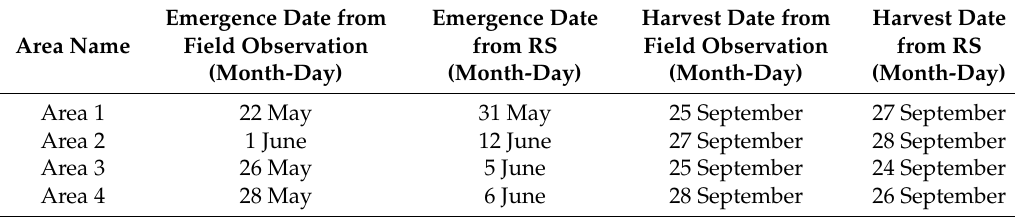
Table 3. Widespread emergence and harvest time from field observation and remote sensing.